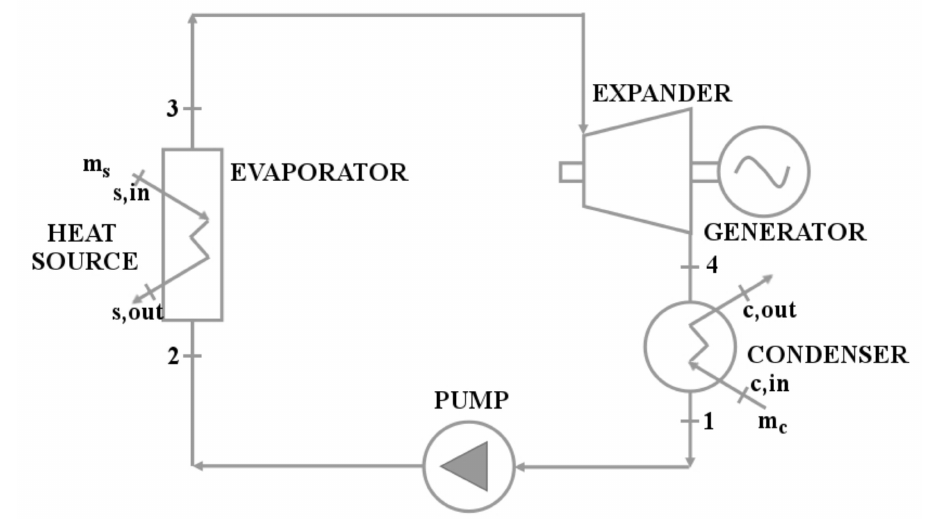
Figure 1. Scheme of the investigated ORC configuration.